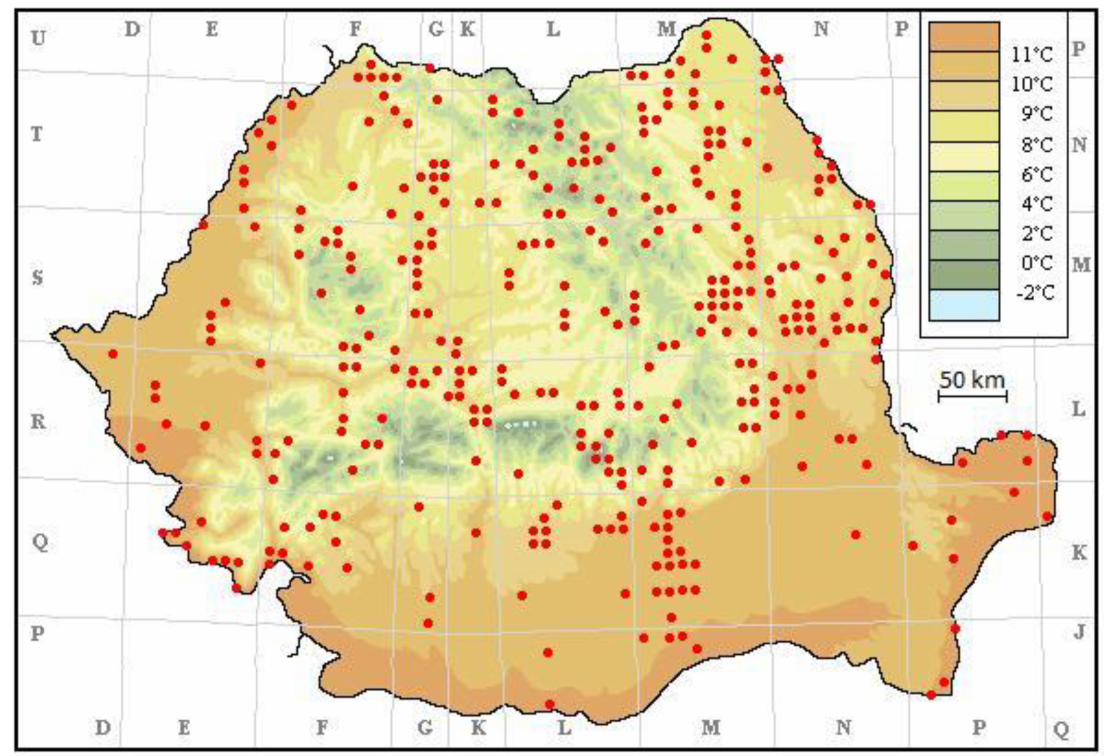
Figure 6. Distribution of Figure 3. Distribution of Salix alba communities. Salix triandra comunities.